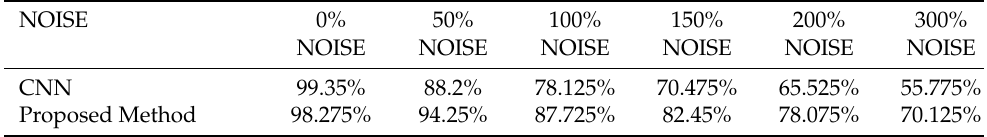
Table 1. Comparison of identification accuracy between CNN and inhibitory